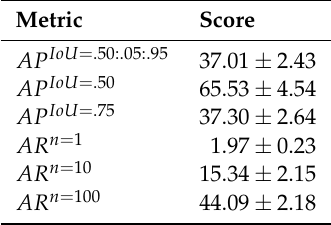
Table 1. Results from the plant instance detection baseline. The reported values are the mean and standard deviation over all ten splits in the 10-fold cross validation